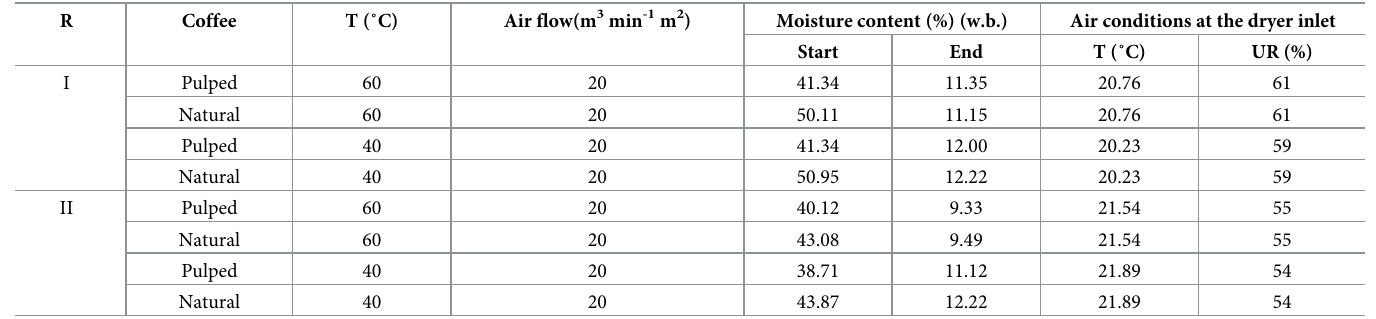
Table 1. Mean values of the product and ambient air conditions for all treatments.